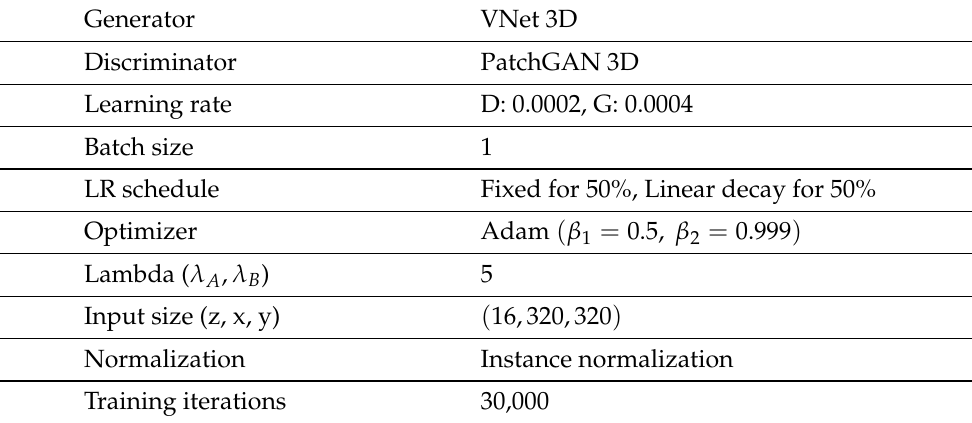
Table 1. Base configurations used for the experiments performed across the two